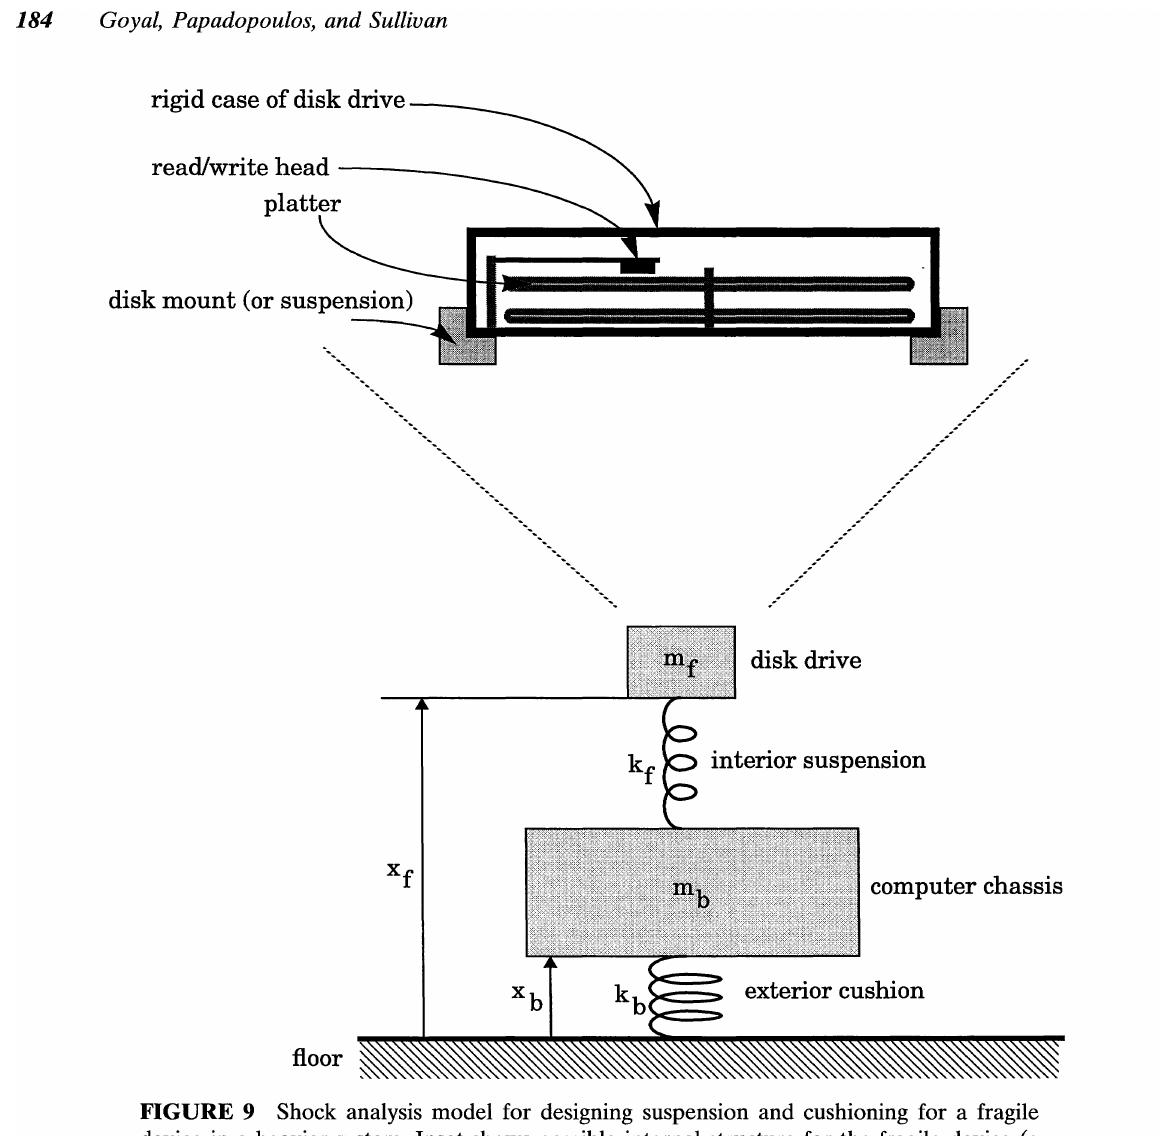
FIGURE 9 Shock analysis model for designing suspension and cushioning for a fragile device in a heavier system. Inset shows possible internal structure for the fragile device (a disk